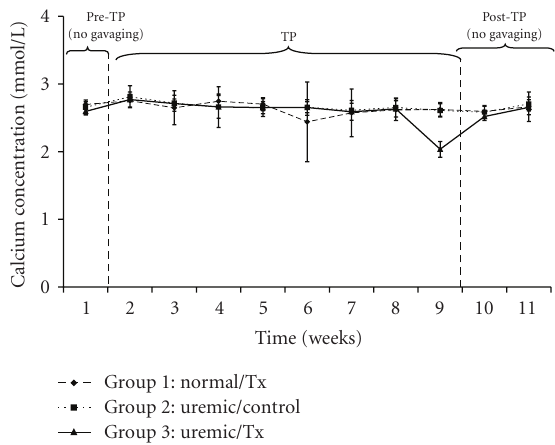
Figure 5: Plasma calcium concentration before, during and after oral administration of APA microencapsulated yeast